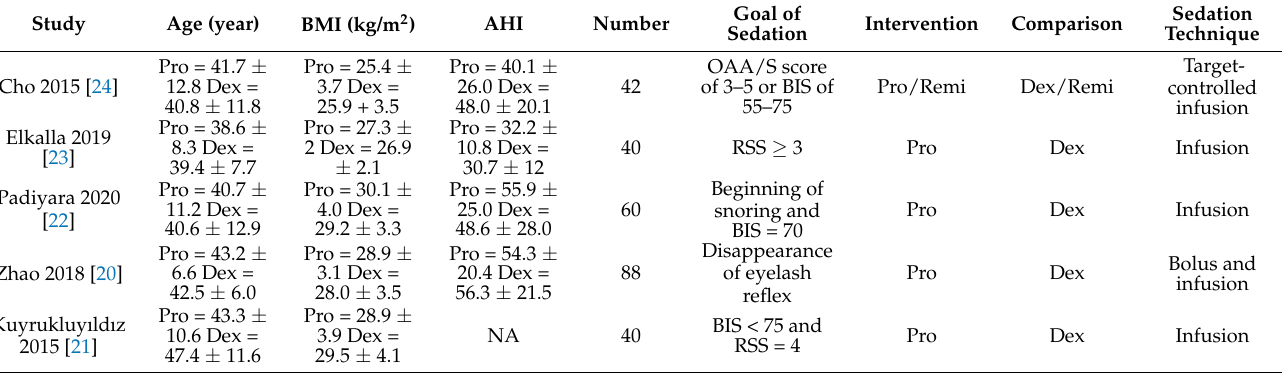
Table 1. Characteristics of included